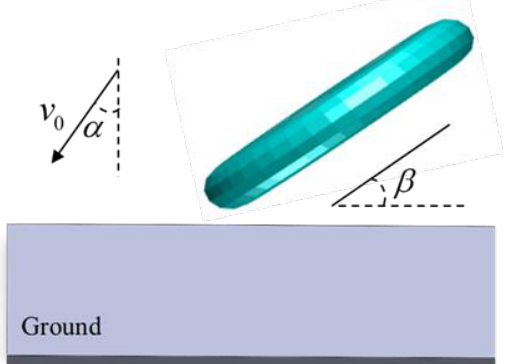
Figure 11. Illustration of the simulation